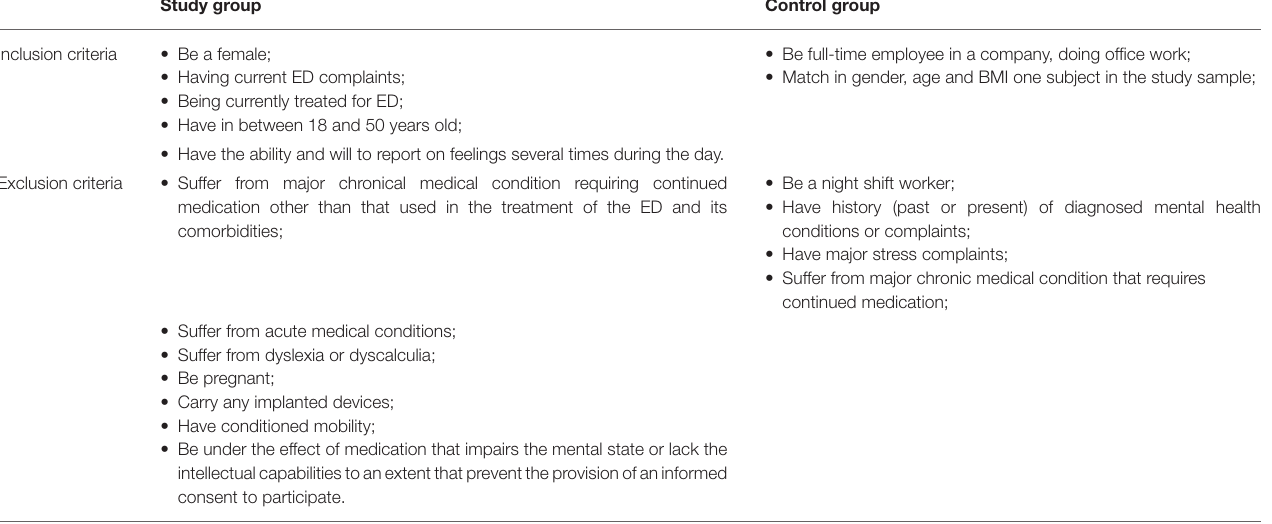
TABLE 1 | Admission criteria: inclusion and exclusion criteria applied for the selection of the participants on the study. Study